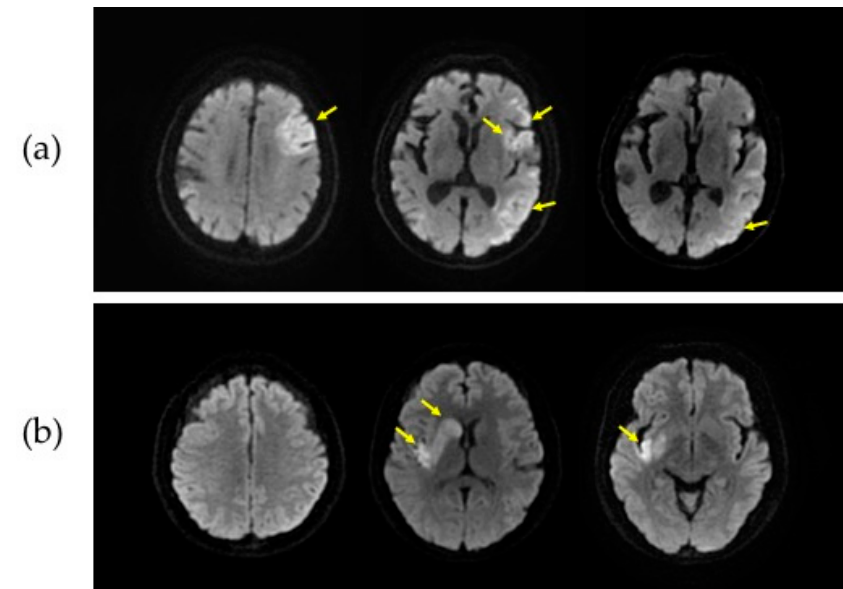
Figure 1. Representative diffusion-weighted magnetic resonance imaging (DWI) slices from two groups. DWI data from a patient with the Alberta Stroke Program Early Computed Tomographic Score (ASPECTS) of 5 ( a ) and the ASPECTS of 7 ( b ) are shown. The slices in the first, second and third column in each patient correspond to the supraganglionic, ganglionic, and infraganglionic levels, respectively. The yellow arrows indicate infarct lesions.